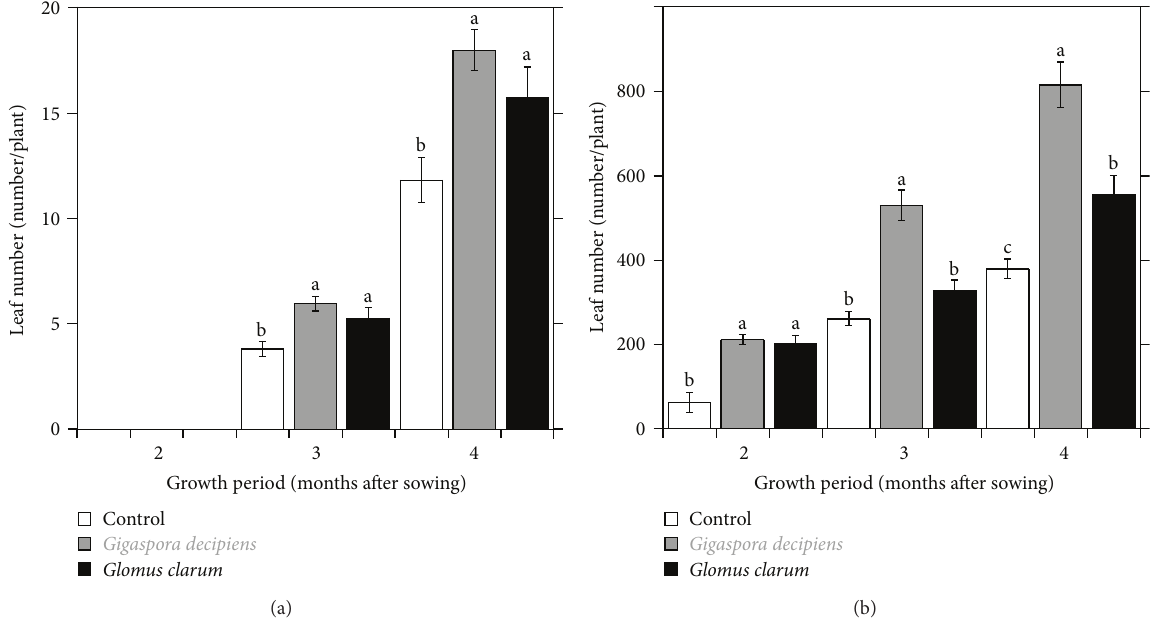
Figure 2: Leaf numbers of M. paniculatus (a) and A. saman (b) inoculated with AM fungi two, three, and four months after sowing. Gray bar: G. decipiens ; black bar: G. clarum ; white bar: control. Different letters for the same month indicate a significant difference at 𝑃 < 0.05 as determined by the Tukey HSD test ( 𝑛 = 20 ). Vertical bars represent standard errors of mean